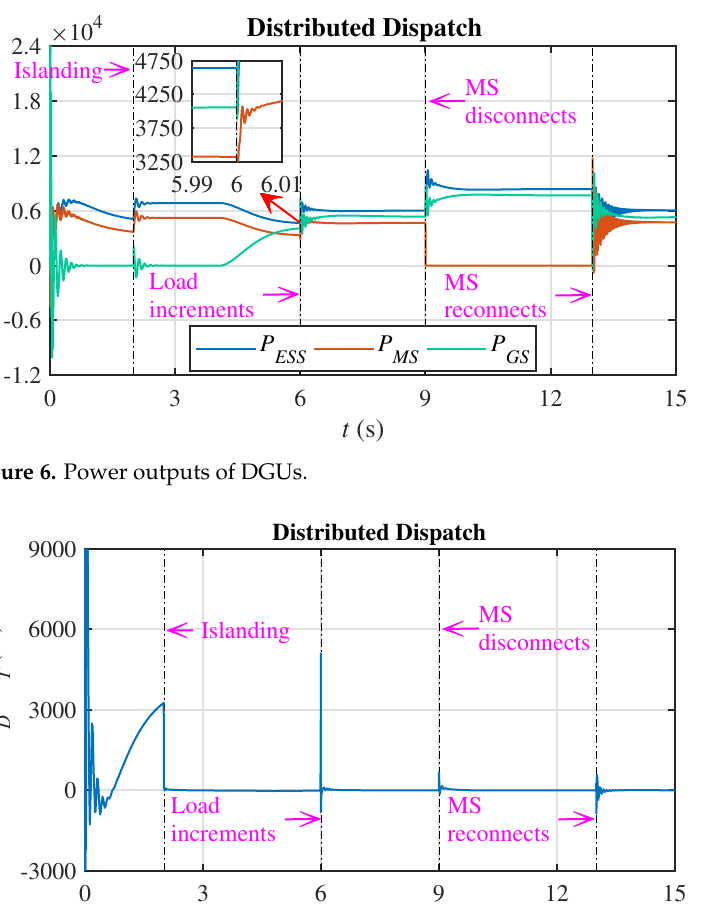
Figure 5. The optimal power dispatch references for DGUs.